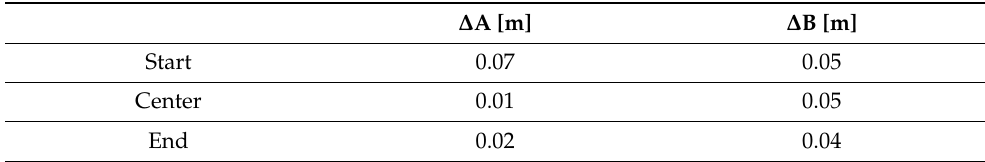
Table 7. SfM co-registering errors.